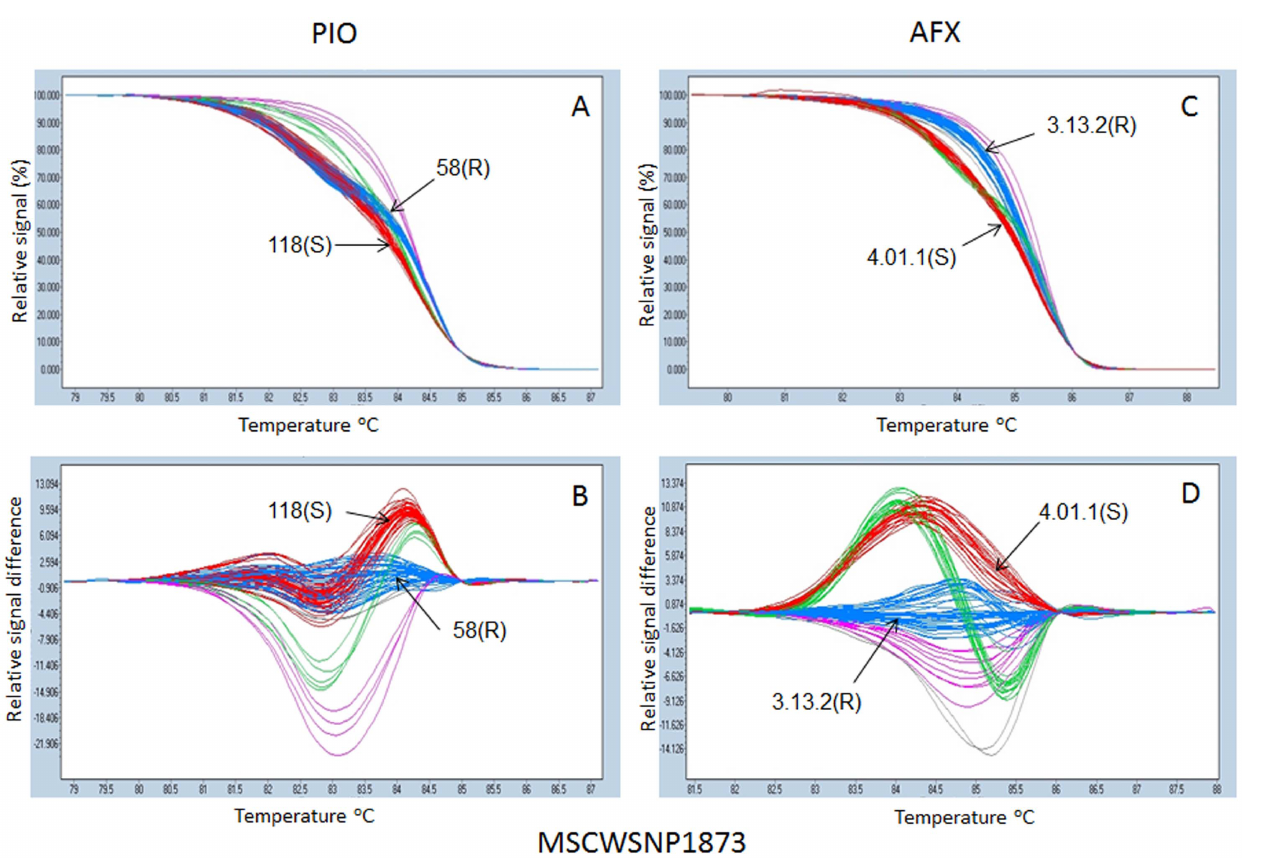
Fig. 3. High resolution melting profiles of SNP markers MSCWSNP1873 in the Pioneer (PIO) (A, B) and Alforex (AFX) (C, D) populations. The real time PCR was performed by LightCycler 480) and the HRM profiles were analyzed using the gene scanning module software. Normalized melting curves (A, C) and temperature shift difference plots (B, D) are presented. Five colors (red, blue, green, pink and grey) represent five distinct groups of genotypes. Melting curves for parents in each population are indicated by arrows. Resistant parents: 58(R) 5 55V50-58(R) (Pioneer) and 3.13.2 (R) 5 CW065006-3-13-2 (R) (Alforex), susceptible parents: 118(S) 5 55V50-118(S) (Pioneer) and 4.01.1(S) 5 CW065006-4-01-1(S)